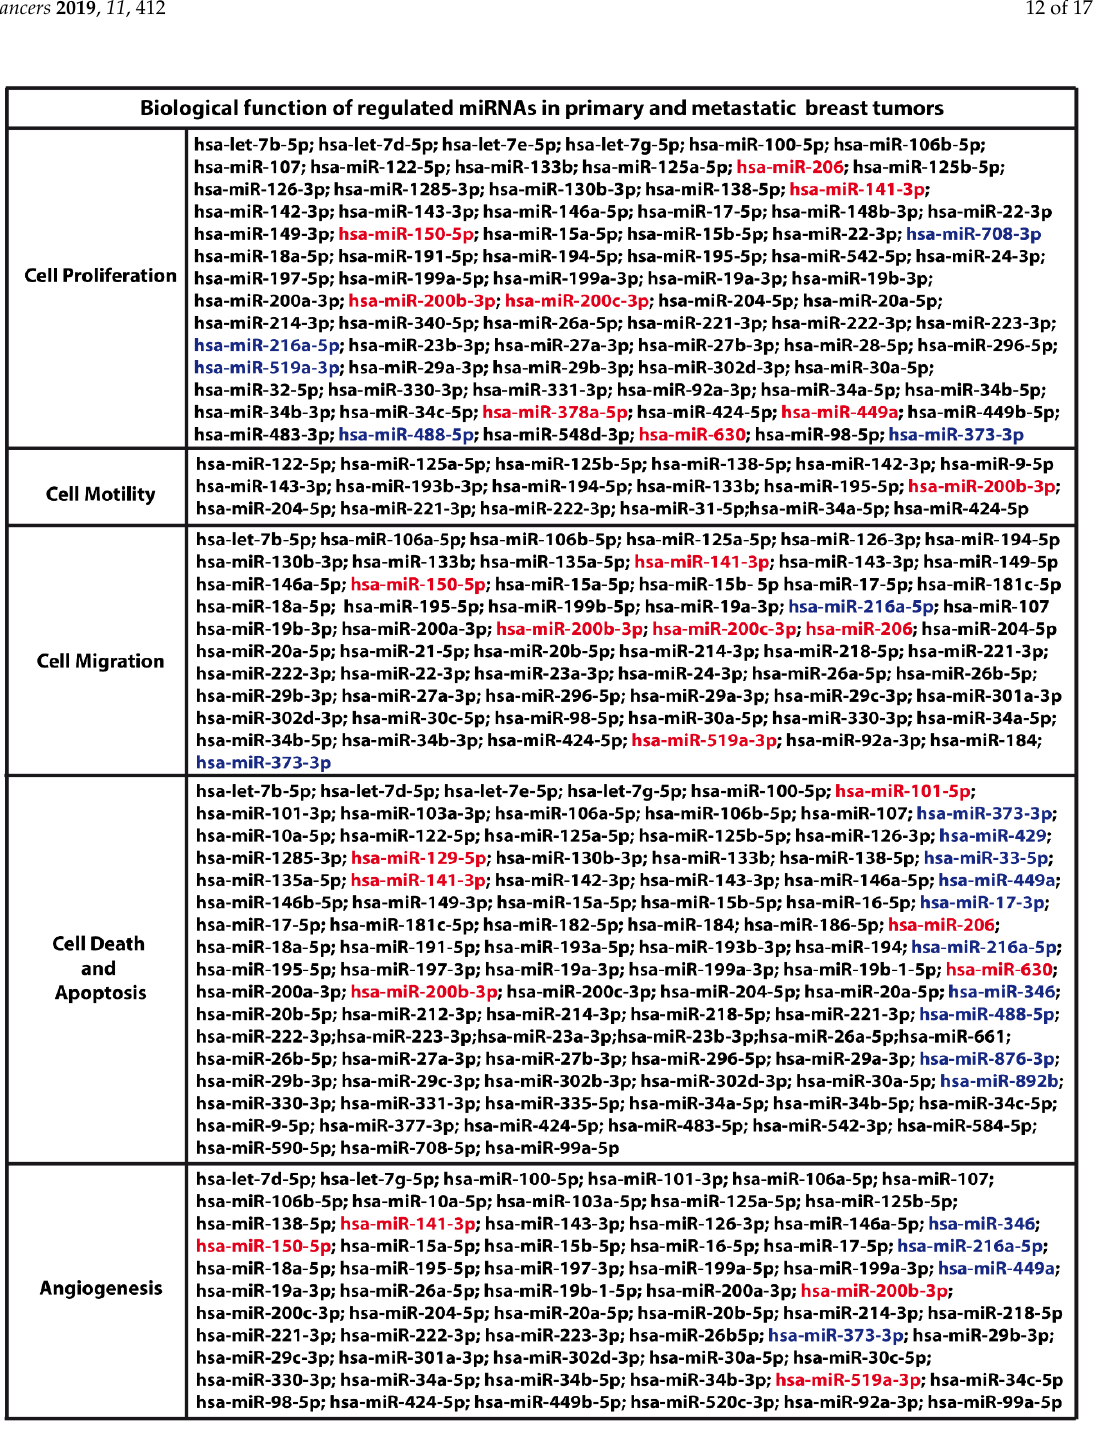
Figure 11. Biological function of miRNAs regulated by estrogens in CAFs derived from primary breast tumors (blue), metastatic breast tumor (black) or in both cell types (red). The analysis was performed by miRò v.2 on validated and predicted targets (number of tools predicting the interaction was at least 6).